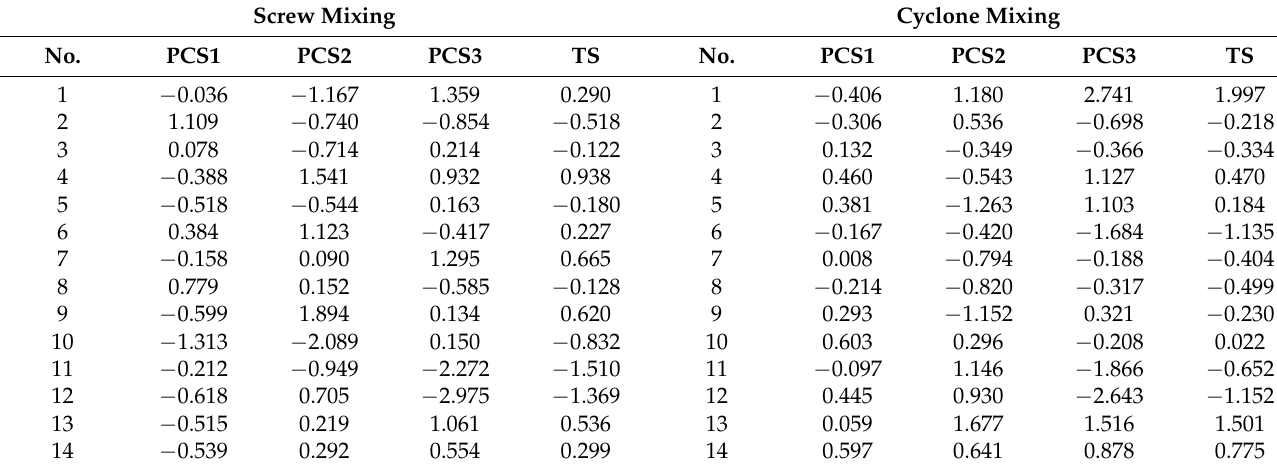
Table 6. Principal component